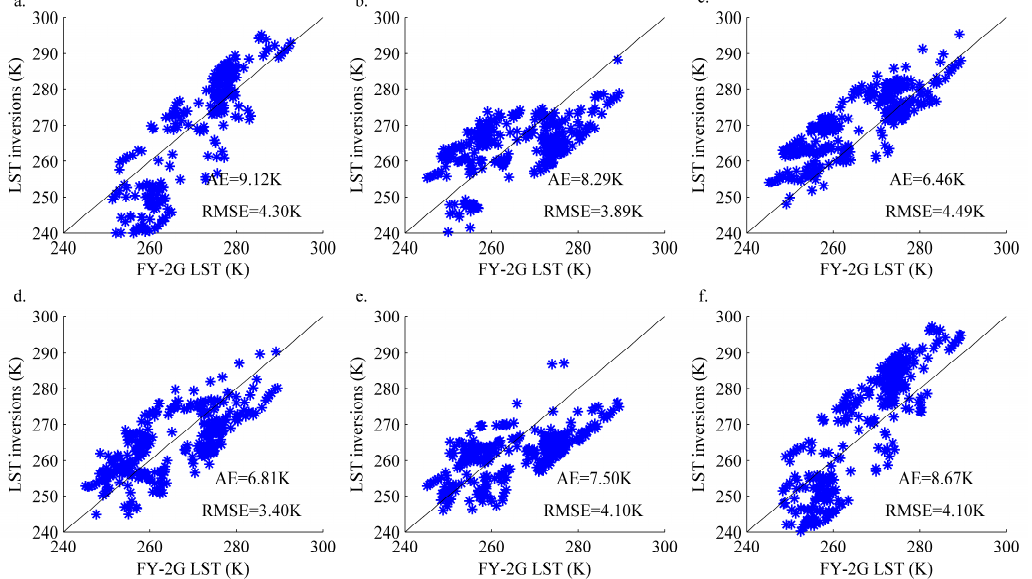
Figure 5. The accuracy analysis of Moon-based LST estimations compared with FY-2G thermal infrared data, representing the results of ( a ) 6.9, ( b ), 10.8, ( c ), 18.7, ( d ), 23.8, ( e ) 36.5 and ( f ) 89.0 GHz